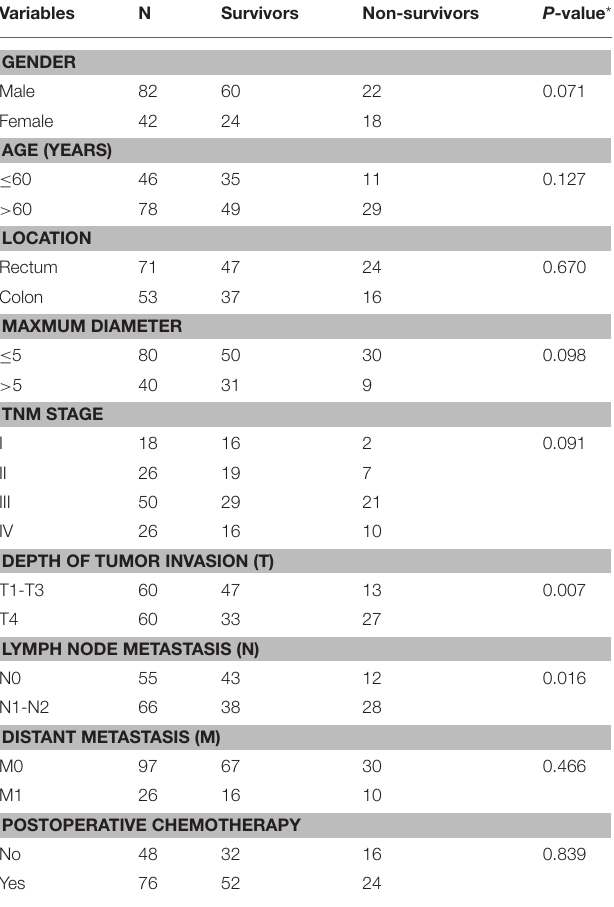
TABLE 1 | The main patient and tumor characteristics, stratified by 3-year survival status.